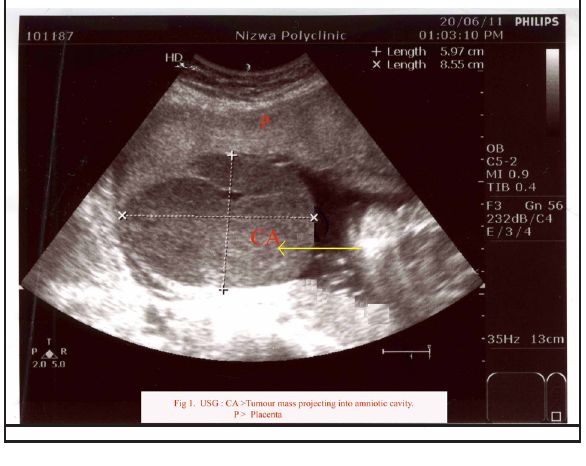
Figure 1. Ultrasound imaging showing placental mass protruding into the amniotic cavity.